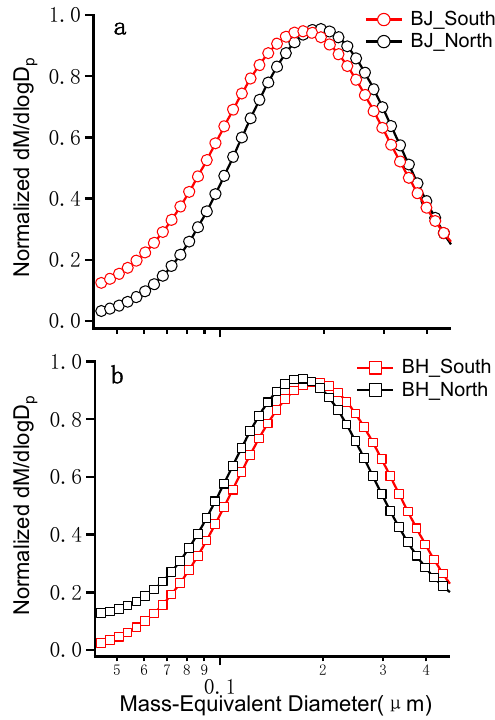
Figure 7. The average rBC size distributions for the urban area (BJ-a) and the ocean area (BH-b) under different air mass back trajectories. The red color represents the southern air mass, and the black color represents the northern air